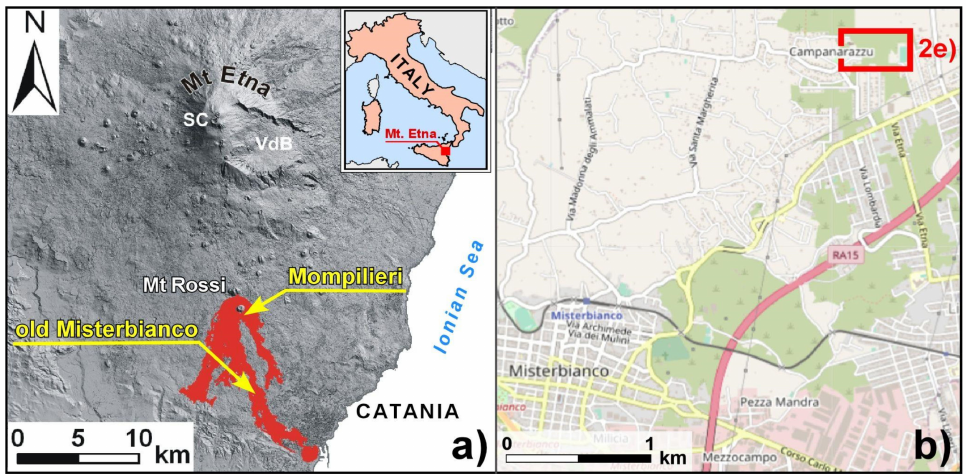
Figure 1. ( a ) Sketch map of the 1669 lava flow with the sites of the “buried” churches of Mom- pilieri and old Misterbianco; ( b ) the old settlement (red box) is today located in a very urbanized area, a few kilometers from the new Misterbianco and the northern outskirts of Catania (base map from OpenStreetMap ®